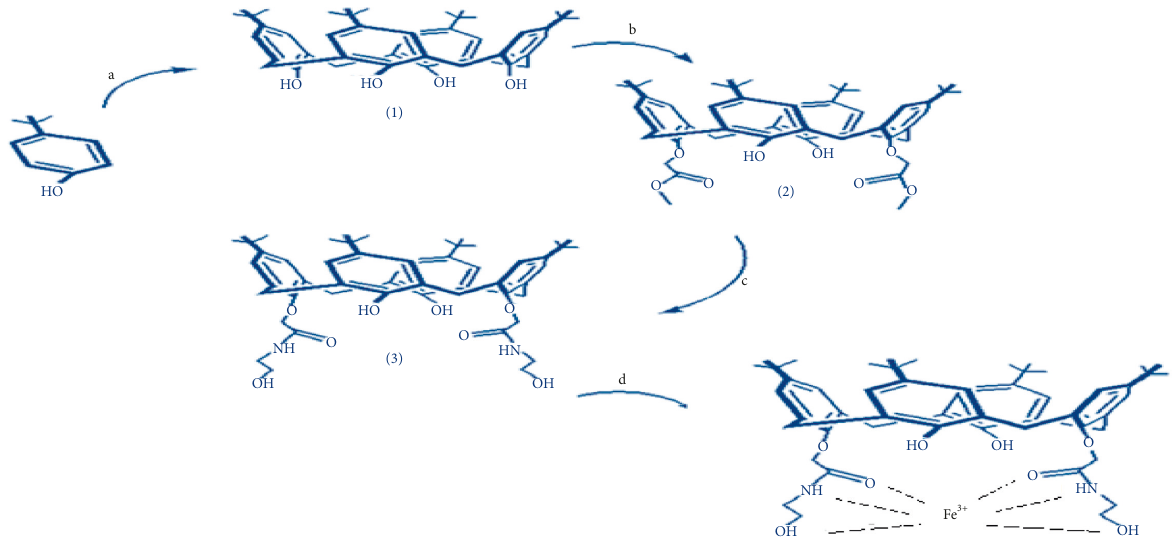
Figure 1: Experimental scheme for the synthesis of 1–3 and Fe 3+ complex of 3 (derivative L). The conditions specified for each step are (a) HCHO/NaOH, (b) KCO 3 /C 4 H 7 BrO 2 , (c) C 2 H 7 NO/CH 3 OH, and (d) FeCl 3